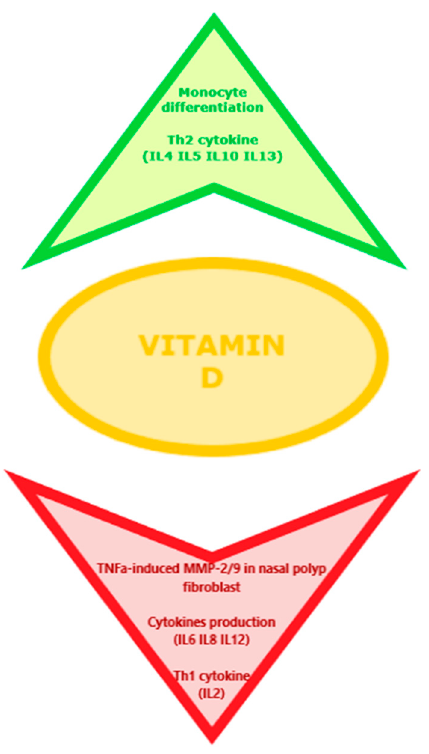
Figure 1. Effects of the VD on the immune pathogenesis of CRS and nasal polyposis. Based on what has been discussed, vitamin D is known to act on both innate (through inhibitory effects on Toll-like receptors) and adaptive immunity (through inhibitory effects on cytokines secretion resulting in inhibition of T-cell proliferation). In addition to its cellular effects, vitamin D is capable of modulating a great variety of pro-inflammatory cytokines, thus playing a key role in the pathogenesis of many allergic disorders [41–43] such as asthma, atopic dermatitis, and food allergies [43–46]. Particularly in allergic diseases, vitamin D acts on the human immune system through inhibitory functions on the growth cycle of human dendritic cells and the functions of T cells, stimulating the secretion of specific cytokines such as IL-10 [47,48]. It has been widely discussed how patients diagnosed with allergic disease are characterized by below normal levels of vitamin D and how this hormonal deficiency leads to a greater severity of symptoms [49–51]. In fact, the metabolite of vitamin D 1,25 (OH) 2VD3 can act by inhibiting T-helper 1 (TH1) and stimulating the responses of TH2 cells. It also stimulates the differentiation of TH17 cells, resulting in upregulation of regulatory T cells (TReg) and type 1 regulatory T cells (TR1). However, 1,25 (OH) 2VD3 also inhibits the proliferation of B lymphocytes and their differentiation into antibody-secreting cells